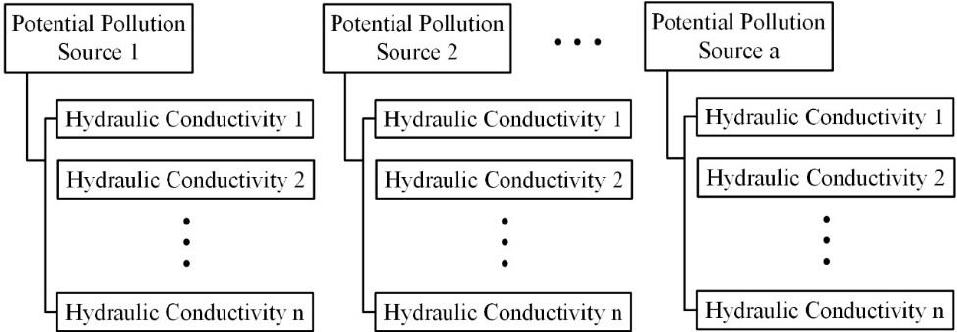
Figure 2. The construction diagram of the concentration field library.